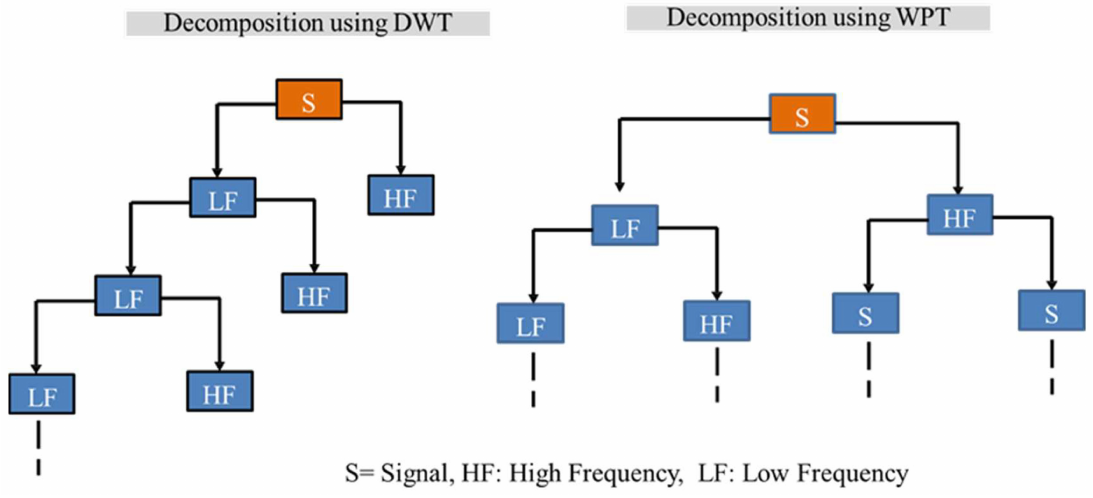
Figure 3. Difference between Discrete Wavelet Transform and Packet wavelet